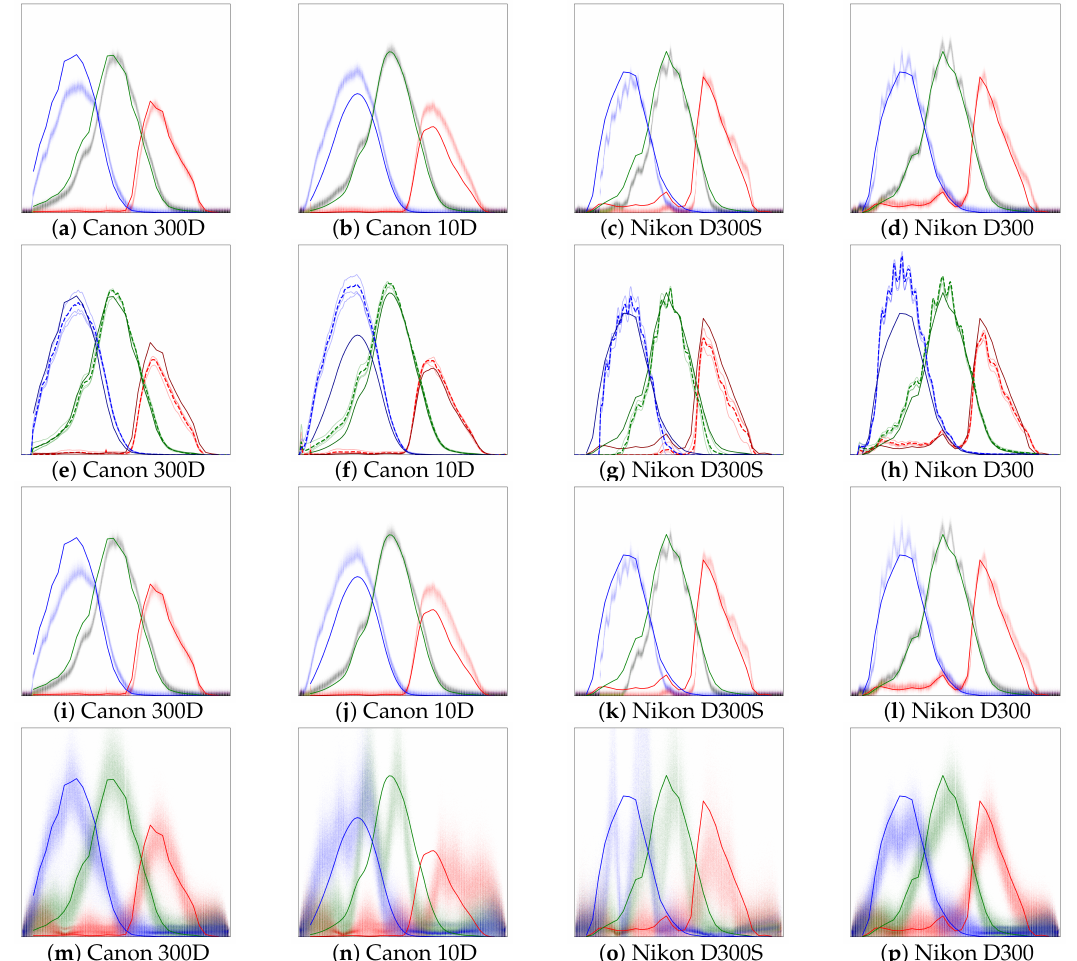
Figure 7. Spectral responses for proposed ( a – d ), baseline ( e – h ), monochromatic only ( i – l ), and color patches only ( m – p ), all over the range of 380–720 nm. The solid line corresponds to the ground truth measures using a monochromator, obtained from References [28,29]. Spectral response results have been scaled by diving all values by the value for the green channel at 550 nm. All ensemble iterates for proposed, monochromatic only, and color patches only methods have been plotted. For the baseline, results for all illuminants have been plotted and also the mean estimate from the three illuminants as dashed line. For Nikon D300S and D300 the results may seem noisy, but the oscillation visible in the spectral responses is also visible in the raw diffraction images. For clarity, the opacity of ensemble iterate points in ( m – p ) is five times that of the other